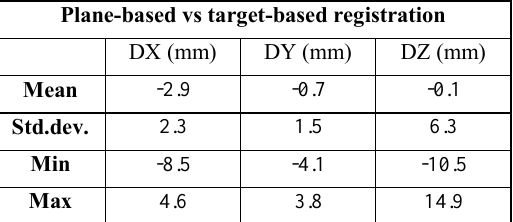
Figure 16. Case Study 2: matrix showing the results of scan pairwise registration using a target-based approach. Average target residuals are displayed using following colours: green < 3.0mm, orange between 3.0 - 10 mm, red > 10.